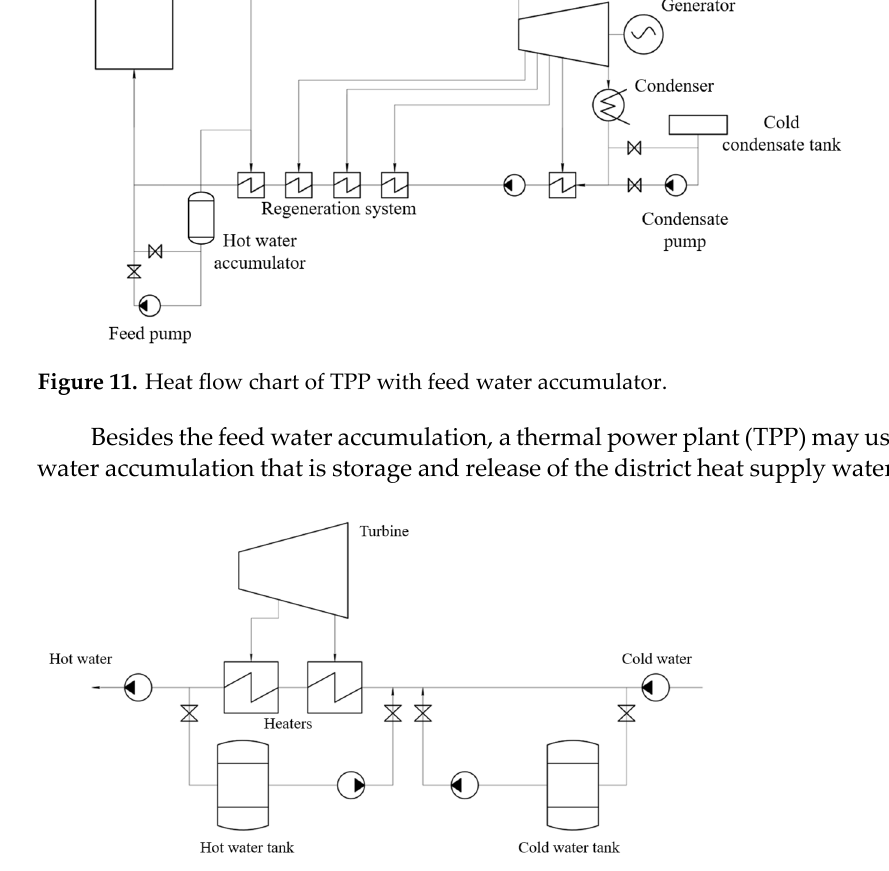
Figure 14. Heat flow chart of a TPP with phase transformation accumulator. Another prospective power block scheme featuring thermochemical heat accumu- lation is energy transformation based on a thermochemical reaction with heat consump- tion and release. Papers [43–45] describe the accumulation of the heat obtained from renewable heat sources by reversible reactions based on calcium. The cycle charge involves the reaction of CaCO 3 synthesis with heat consumption in a carbonator. In the discharge, it dissociates